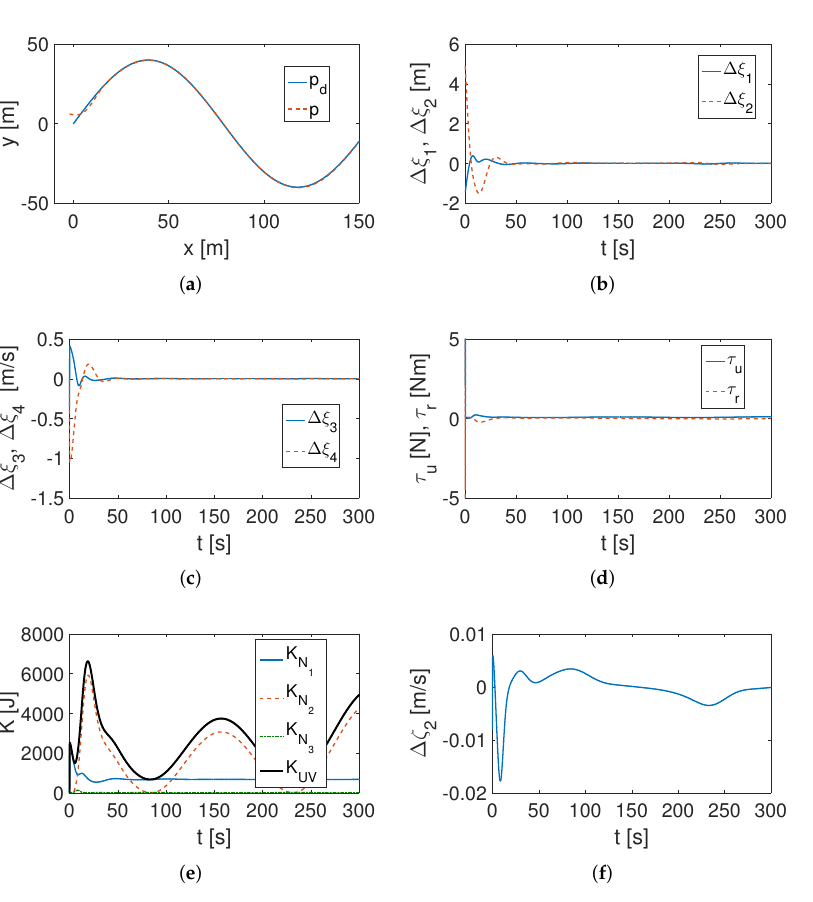
Figure 4. Simulation results for ROPOS QV controller and sine trajectory: ( a ) desired and realized trajectory; ( b ) position error states; ( c ) velocity error states; ( d ) applied force and torque; ( e ) kinetic energy time history; and ( f ) error ∆ ζ 2